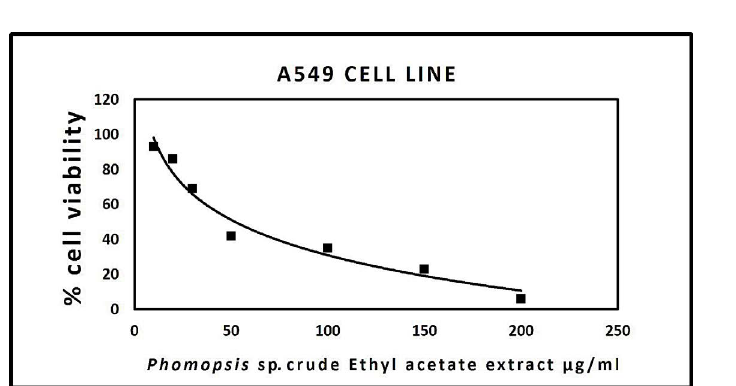
Fig. 8. Graph representing anticancer activity of Phomopsis sp., crude endophytic fungal Ethyl Acetate Extract in A549 Cell